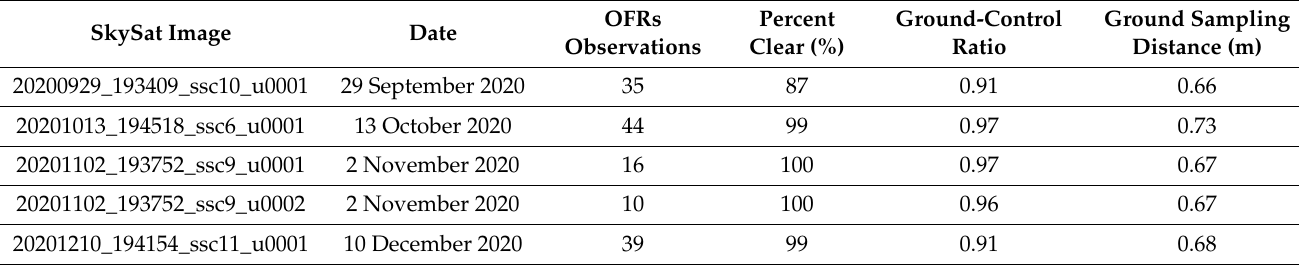
Table 3. SkySat image identification, acquisition date, number of OFRs surface area observations per image, percent clear (indicates the presence or absence of cloud cover; higher values indicate fewer clouds), ground-control ratio (defines the image positional accuracy; values closer to 1 mean higher accuracy), and ground-sampling distance in meters.